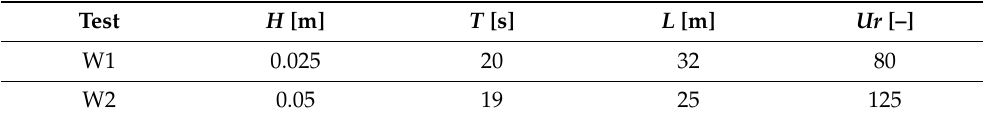
Table 1. Characteristics of the two